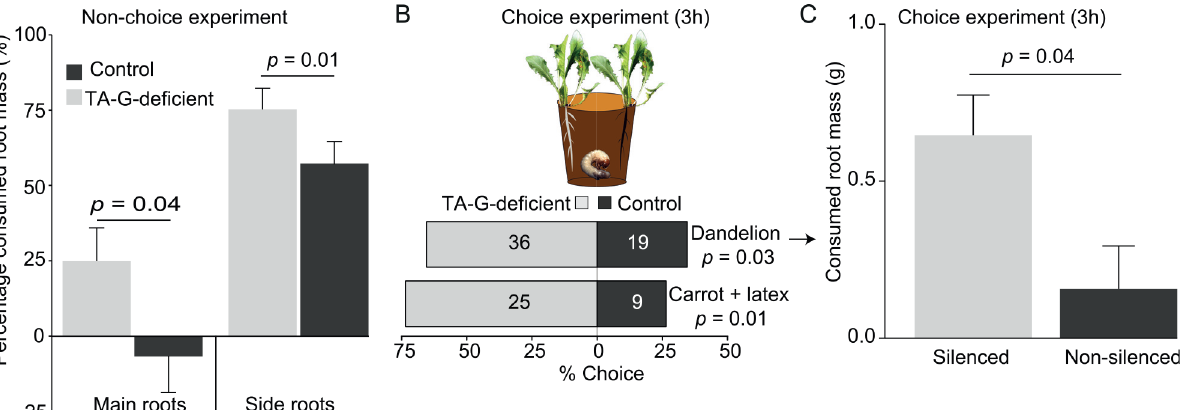
Fig 3. Silencing of the germacrene A synthase gene ToGAS1 increases M . melolontha feeding. A. In a nonchoice experiment, TA-G-deficient lines lost more main and side root mass than control lines after 10 d of feeding by M . melolontha relative to undamaged control plants of each accession ( “ relative root mass ” ) (Kruskal-Wallis rank sum test, n = 36). B. TA-G-deficient T . officinale (top bar) and carrot seedlings painted with latex from TA-G-deficient T . officinale (lower bar) were preferred by M . melolontha over controls after three hours of feeding (binomial test). Diagrams show pooled data of all possible pairwise comparisons of individual TA-G-deficient and control lines. Numbers inside bars refer to number of larvae. C. M . melolontha consumed more root mass from TA-G-deficient T . officinale seedlings compared to control seedlings in a choice experiment after 4 h (paired Student ’ s t test, n = 81). Underlying data can be found in S1